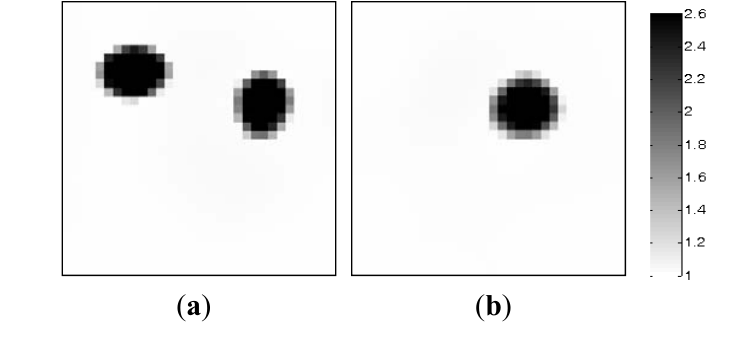
Table 5. Image errors